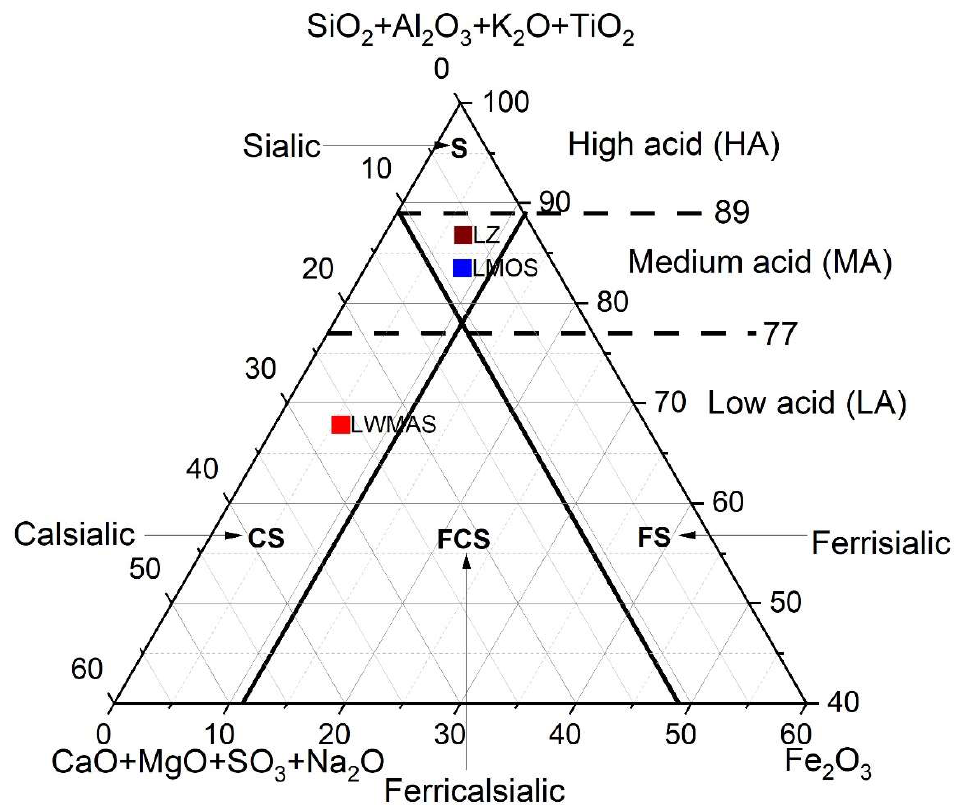
Figure 6. Positions of the tested samples of ash compared to Vassilev’s [48] chemical classification ash.